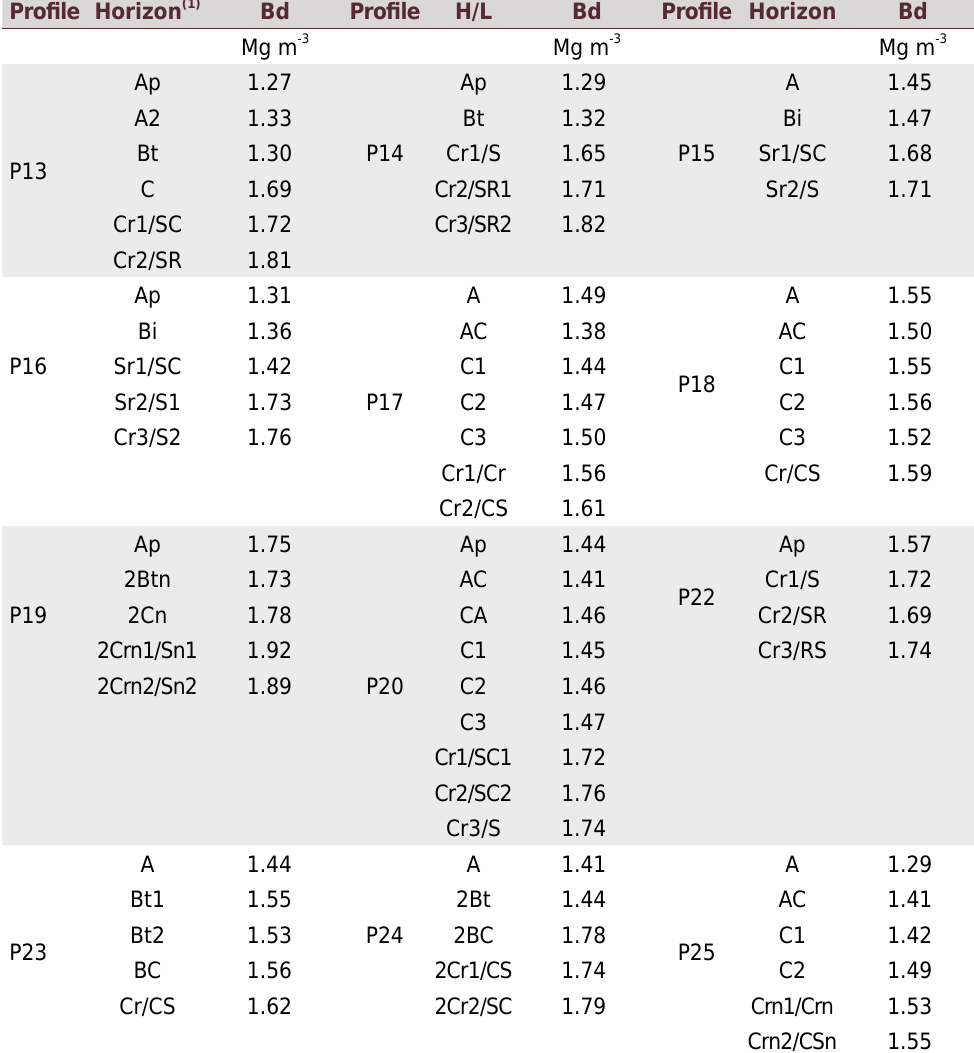
Table 3. Bulk density along the regolith profiles in the Northeast (Santos,